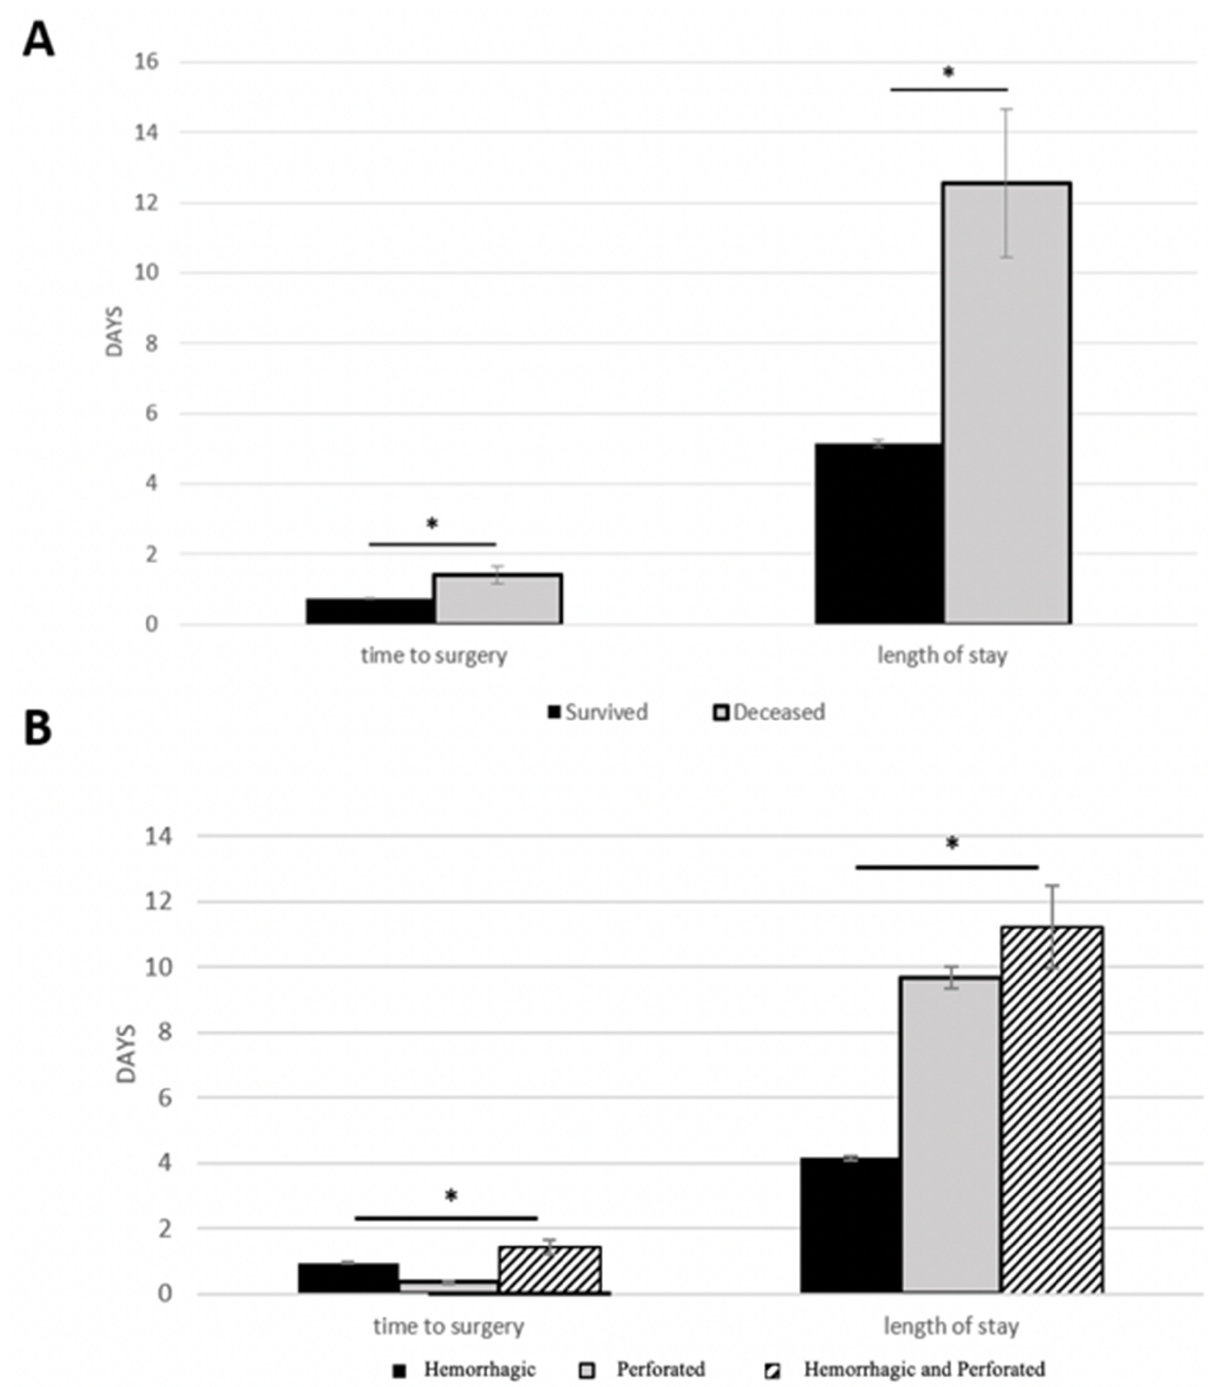
Figure 3. Time to surgery and Hospital Length of Stay (HLOS) in adults. Time to surgery and HLOS were plotted based on survival ( A ) and on ulcer type ( B ). An asterisk (*) indicates significance ( p < 0.05). The three subtypes of ulcers include: hemorrhagic ulcer, perforated ulcer, and both hemorrhagic perforated ulcers. Standard error bars were calculated using standard deviation and N values from Tables 2 and 4.